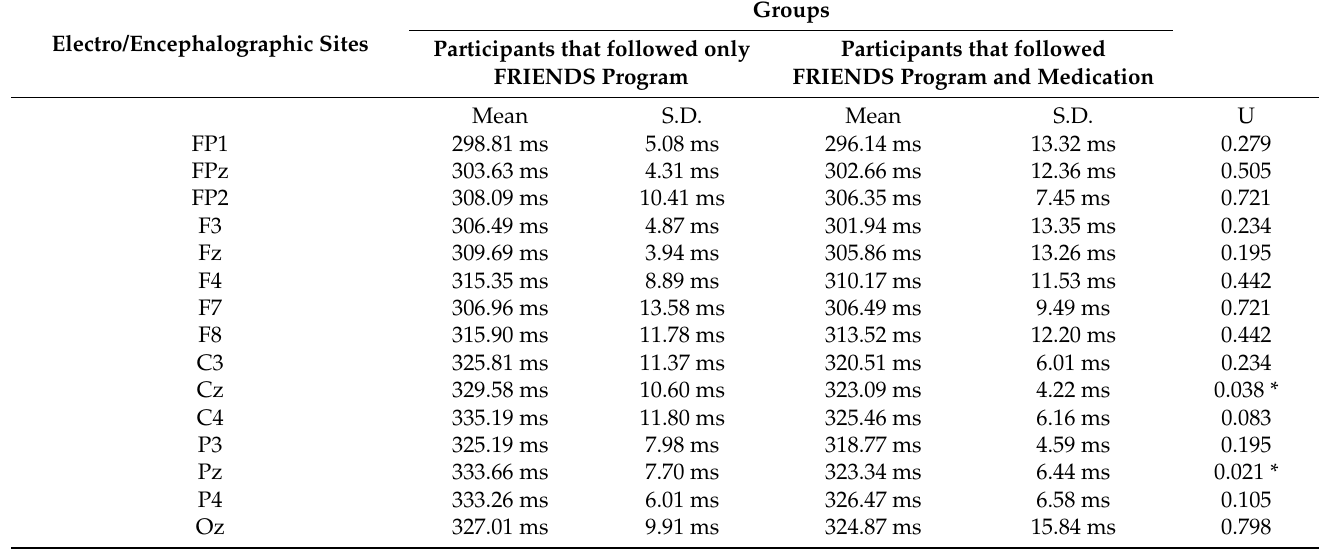
Table 3. Mean scores, standard deviations, and significance of P300 latency in participants with GAD that followed only the cognitive behavioral psychotherapeutic program and children and adolescents with GAD that underwent cognitive behavioral psychotherapeutic program along with SSRIs medication. Statistical significance of all brain areas that were recoded. Groups Electro/Encephalographic Sites Participants that followed only Participants that